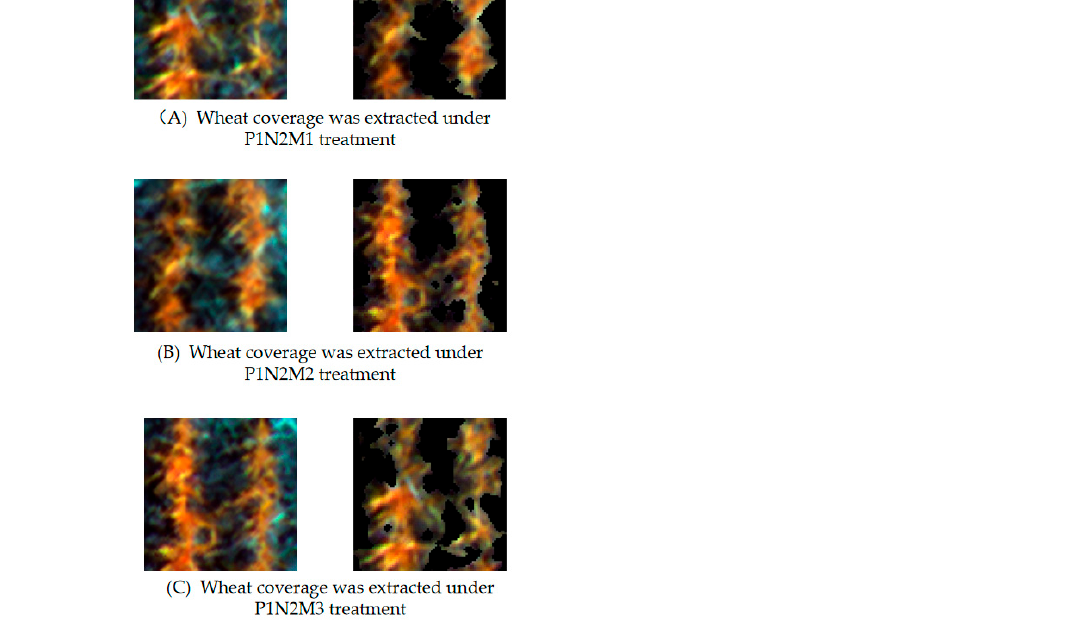
Figure 3. Wheat coverage of variety 1 (P1) in treatments with the same nitrogen fertilizer rate (N2) and different wheat densities: ( A ) M1, ( B ) M2, and ( C ) M3.